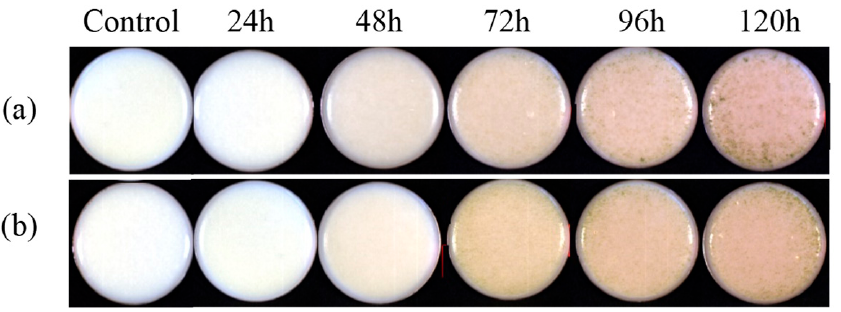
Figure 1. Pseudo color images of A. flavus growing at different time intervals on MAM. Pseudo color images of medium inoculated ( a ) NRRL 3357 with concentration of 10 2 spores mL − 1 ; ( b ) NRRL 3357 with concentration of 10 4 spores mL − 1 .